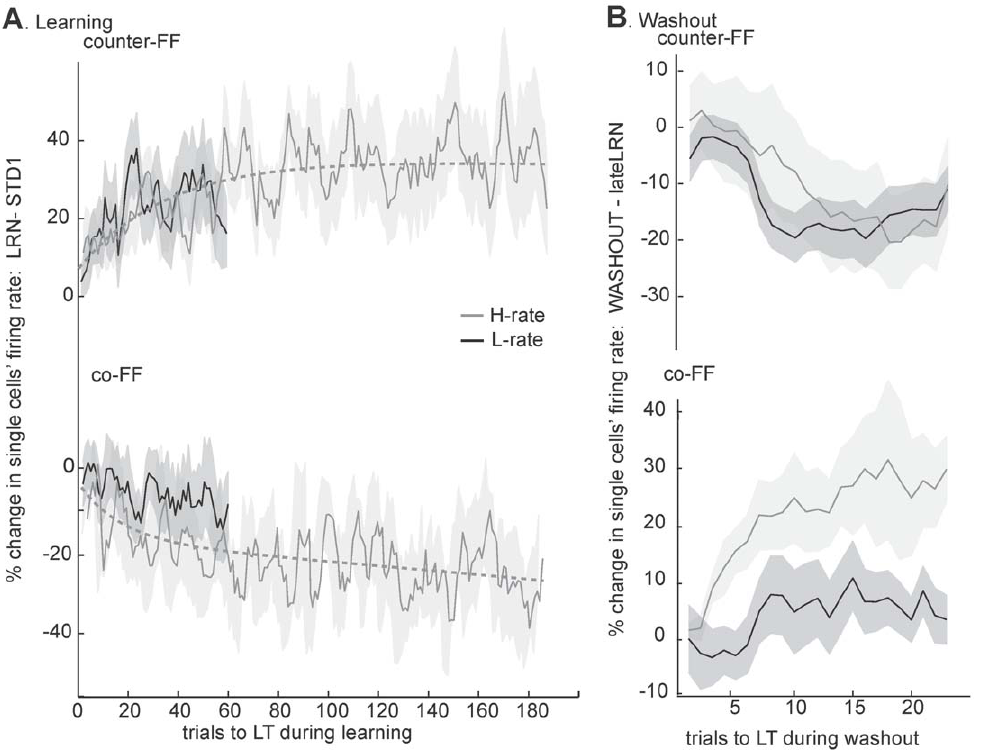
Figure 5. Different dynamics in counter-FF and co-FF cells under L-rate and H-rate as a function of trial number. Figure depicts analyses of cells with PDs in the range 2 135 u , nPD ,2 45 u (counter-FF, top) and range 45 u , nPD , 135 u (co-FF, bottom) (A)Dynamics of changes in activity during adaptation trials to the learned target (LT) relative to standard trials in the first learning day. Counter-FF cells showed increased activity (p , 0.01) under L-rate (number of cells=29) and H-rate (number of cells=17), with similar magnitudes (p . 0.5) in the two conditions, for the same number of trials. In contrast, co-FF cells showed a significant decrease in activity only under H-rate (number of cells=21, p , 0.01), whereas changes under L-rate (number of cells=36) were not significant (p . 0.1). (B)Changes in activity in movements to the learned target along washout (standard trials) relative to activity on the last 10 force-field trials. Counter-FF cells decreased their activity significantly (p , 0.01) and similarly under H-rate as compared to L-rate (number of cells=18 and 33, respectively. p . 0.5). Co-FF cells showed a significant increase only under H-rate (number of cells=13, p , 0.01) but not under L-rate (number of cells=23, p . 0.1). Shaded areas denote SEM.